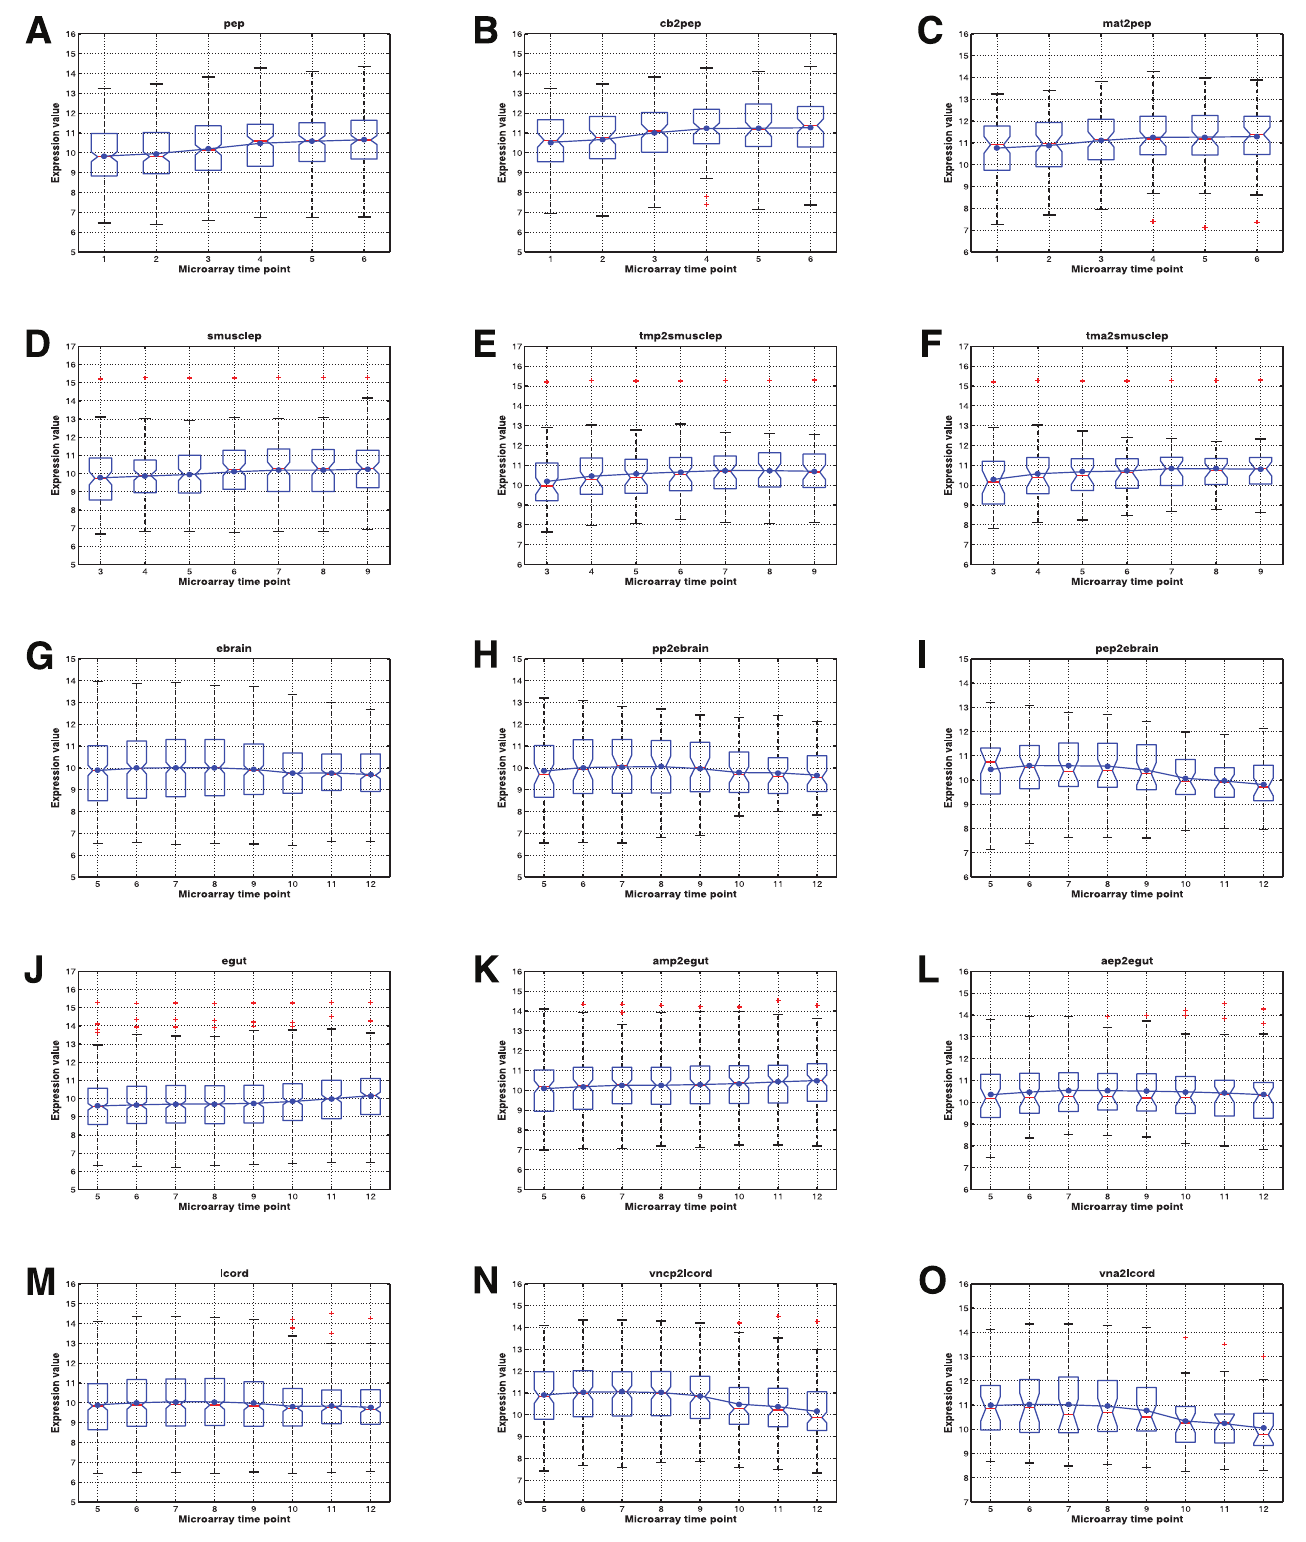
Figure 1. Dynamics of Gene Expression Detected with Microarray Experiment with Respect to Sets of Anatomical Structures Selected to Form Functional Units The boxes have lines at the upper, median, and lower quartile values. Whiskers extend from each end of the box to the adjacent values in the profile data. The most extreme values are within 1.5 times interquartile range from the ends of the box. Outliers (marked with red plus signs) are data beyond the ends of the whiskers. Average microarray profiles are shown in blue continuous lines.